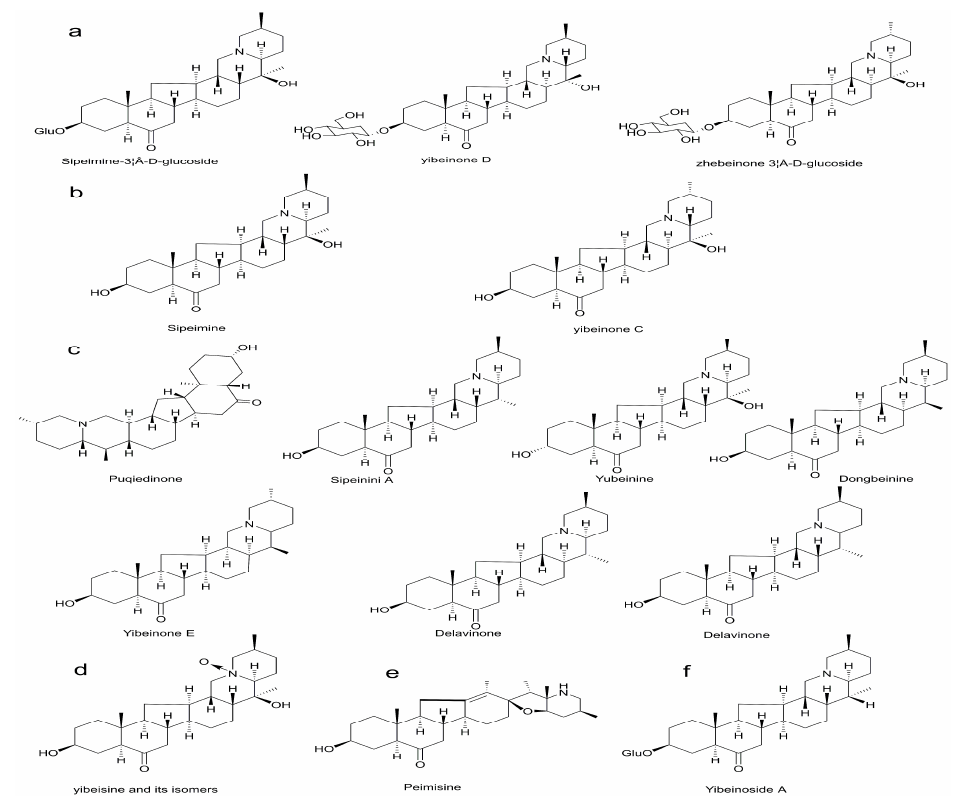
Figure 2. Structure of ( a ) Sipeimine-3 β - D -glucoside and its isomers, ( b ) Sipeimineand and its isomers, ( c ) Puqiedinone and its isomers, ( d ) Yibeisine and its isomers, ( e ) Peimisine, and ( f ) Yibeinoside A.